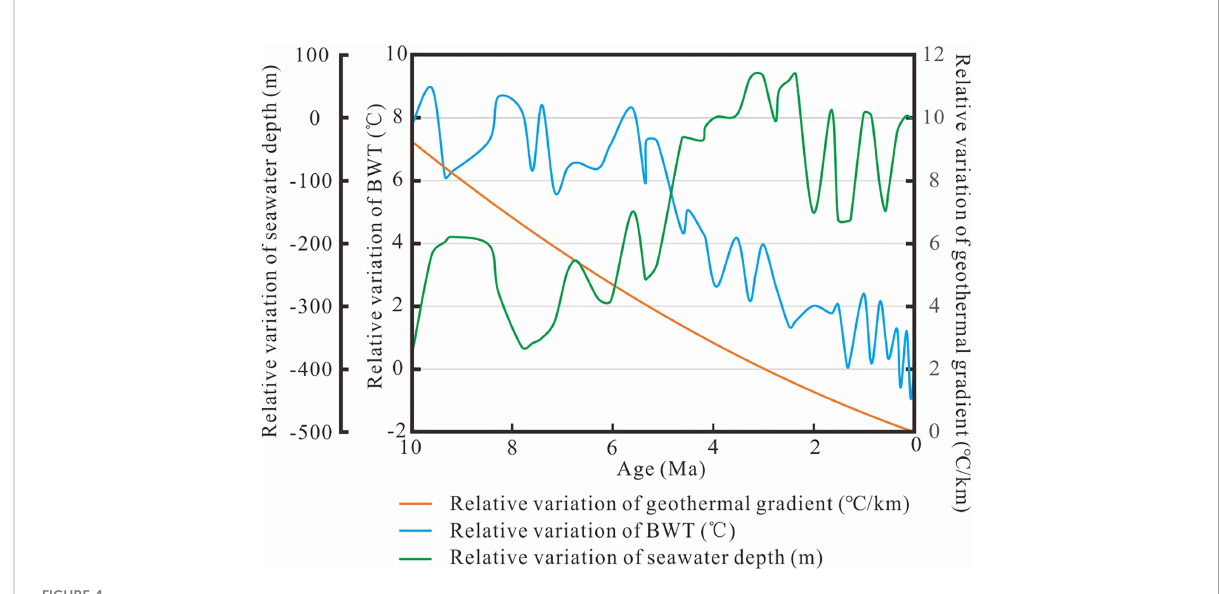
FIGURE 4 Relative trend of the paleo-parameters used to simulate the historical variation in the